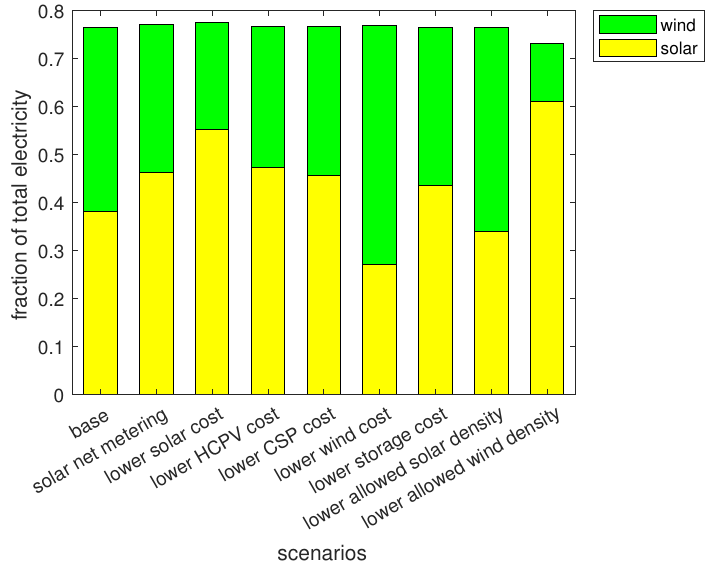
Figure 10. Solar and wind technologies’ share of total electricity production (energy) in 2050 for the base case and sensitivity